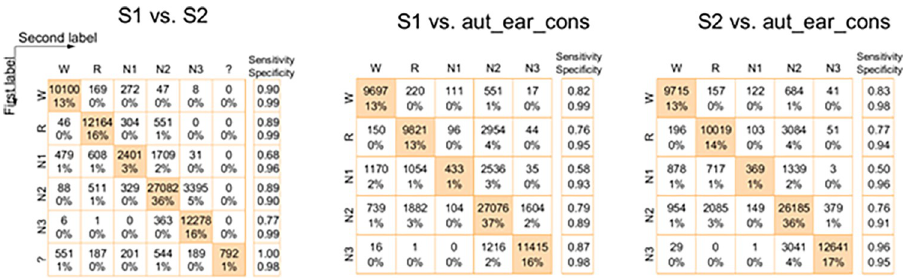
Fig 4. Confusion matrices for three comparisons of raters/methods over all nights. The classes are W(Wake), R (REM-sleep), N1 (N1-sleep), N2 (N2-sleep), N3 (N3-sleep), ‘?’ (scorer could not classify). The numbers indicate how many 30-sec epochs were classified with this combination of scores. The ‘%’ indicates the percentage of epochs relative to the total number of epochs. Numbers in the orange diagonal indicate agreement. In the left matrix, first label is scorer1 based on PSG and second label is scorer2 based on PSG. In the middle matrix, first label is scorer1 based on PSG and second label is an automatic algorithm based on consensus of the two scorers. The right matrix is similar to the middle, just with scorer2 instead of